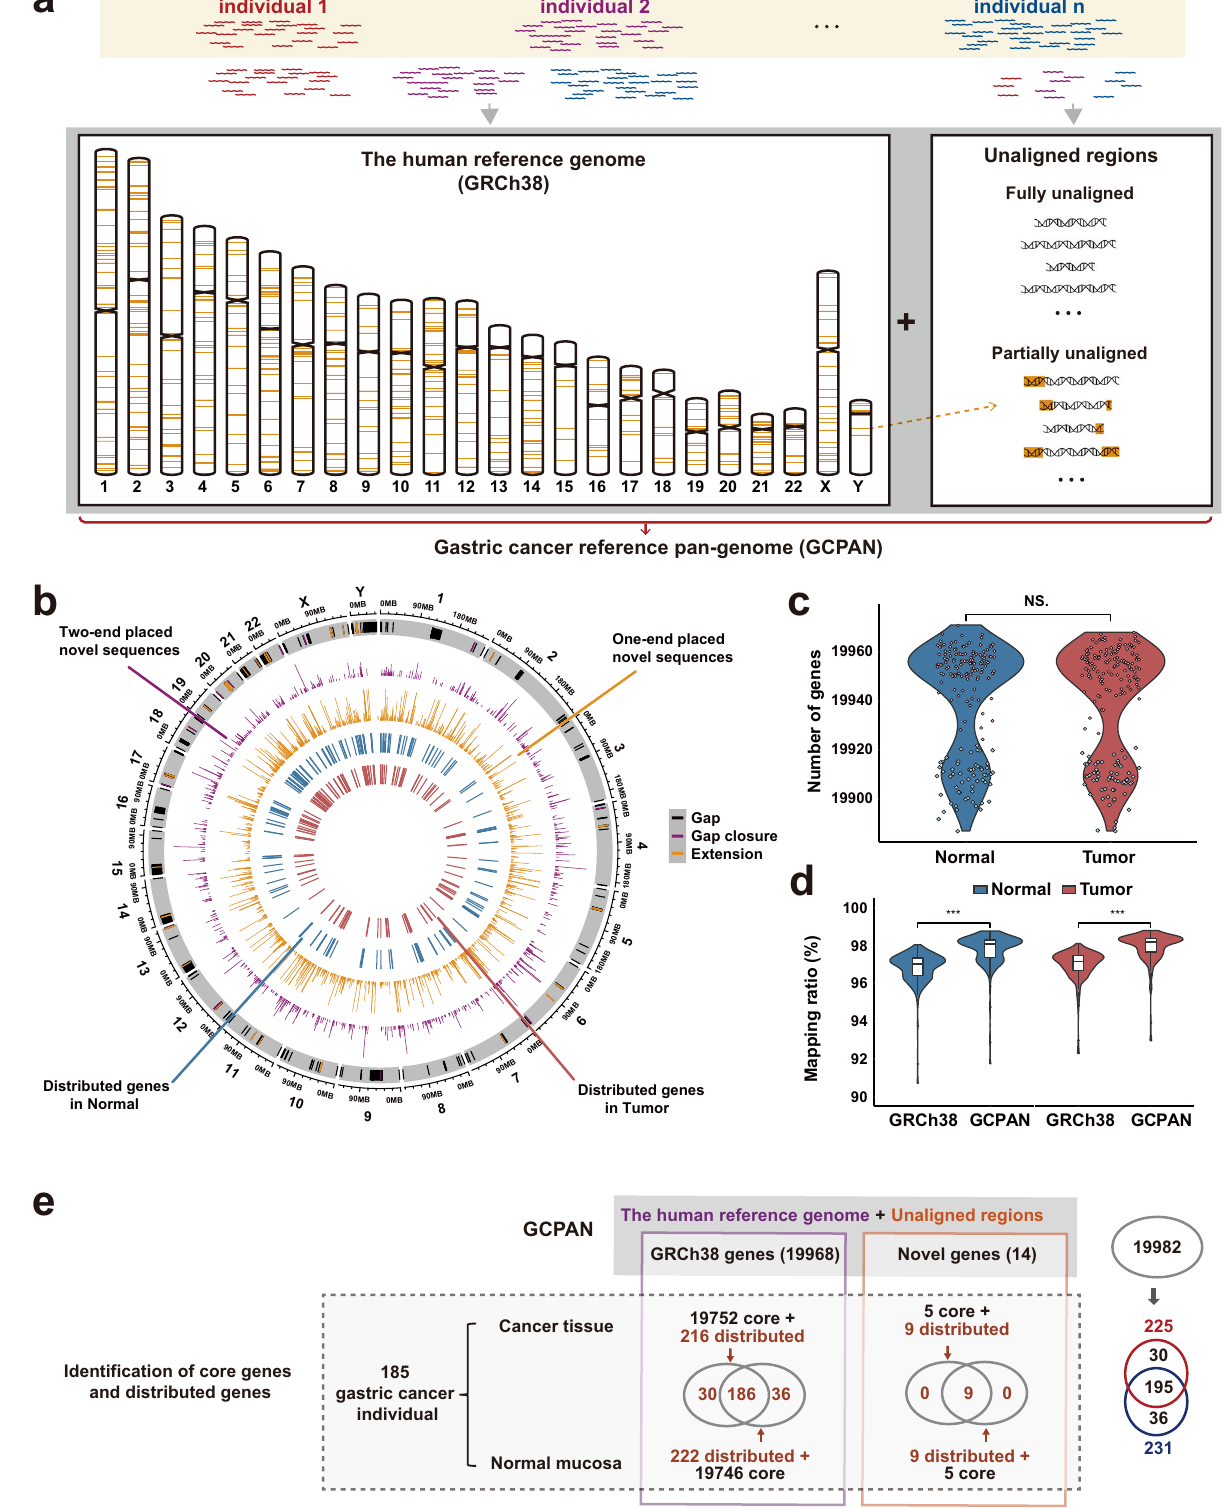
Two-end placed novel sequences